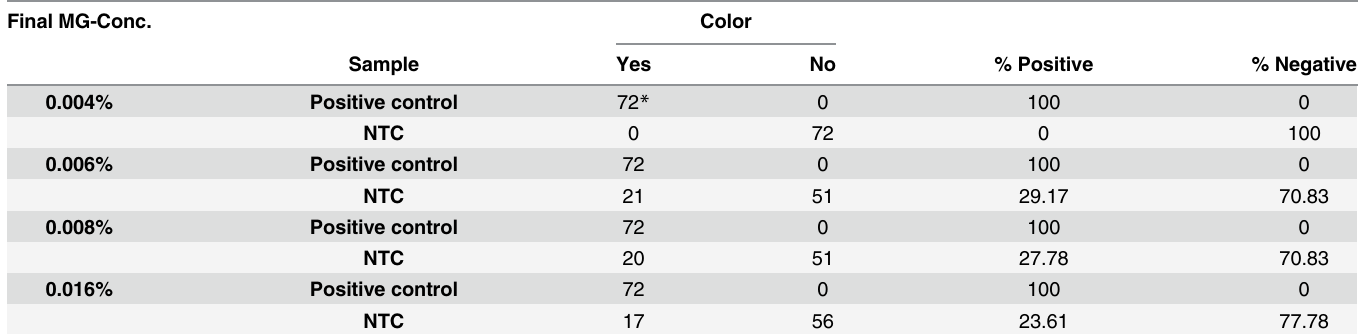
Table 1. Determination of the optimum MG concentration for use in the LAMP assay. Final